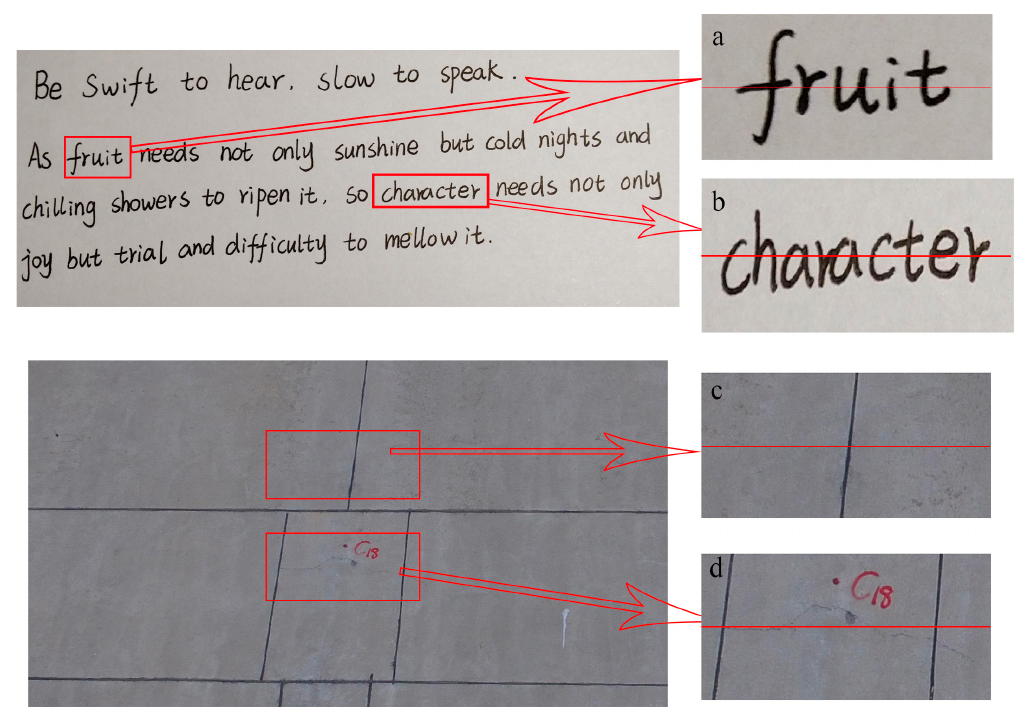
Figure 1. Two typical high-contrast images. And ( a – d ) are four example parts of the text image and the crack image.